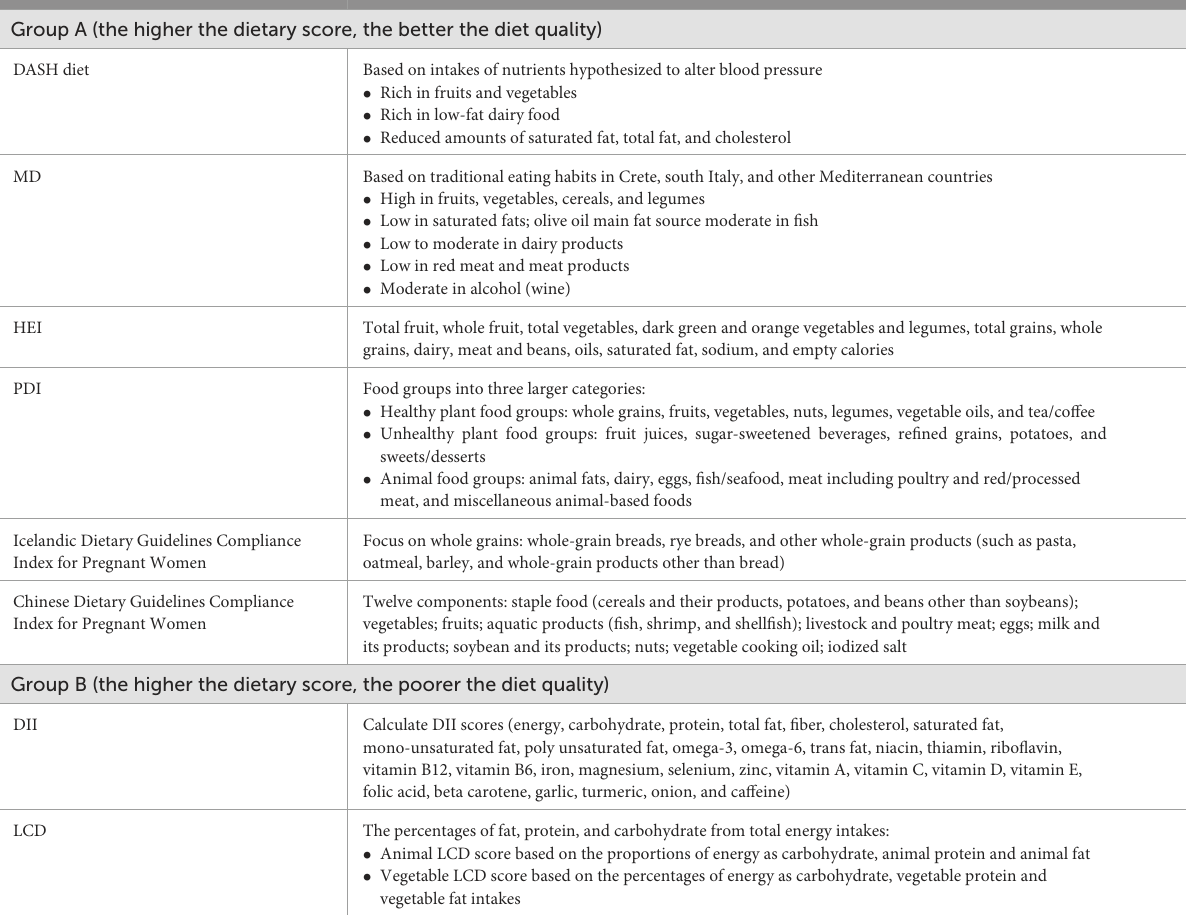
TABLE 5 Dietary characteristics. Diet